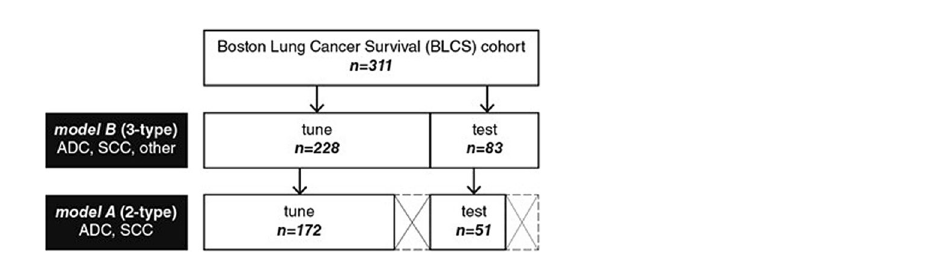
Figure 1. Dataset breakdown for model A and model B. Patients were categorized into three groups; ADC, SCC, and an “Other” category that comprised all other NSCLC histology subtypes. Similar to data presented in Table 2 for model A, model B was fine-tuned using the same BLCS dataset, but with the inclusion of all other histology types. This translated to a tuning-set with 120 ADC, 52 SCC, and 56 patients with “Other” histology types, and a test-set with 35 ADC, 16 SCC, and 32 patients with “Other” histology types (summarized in Fig.